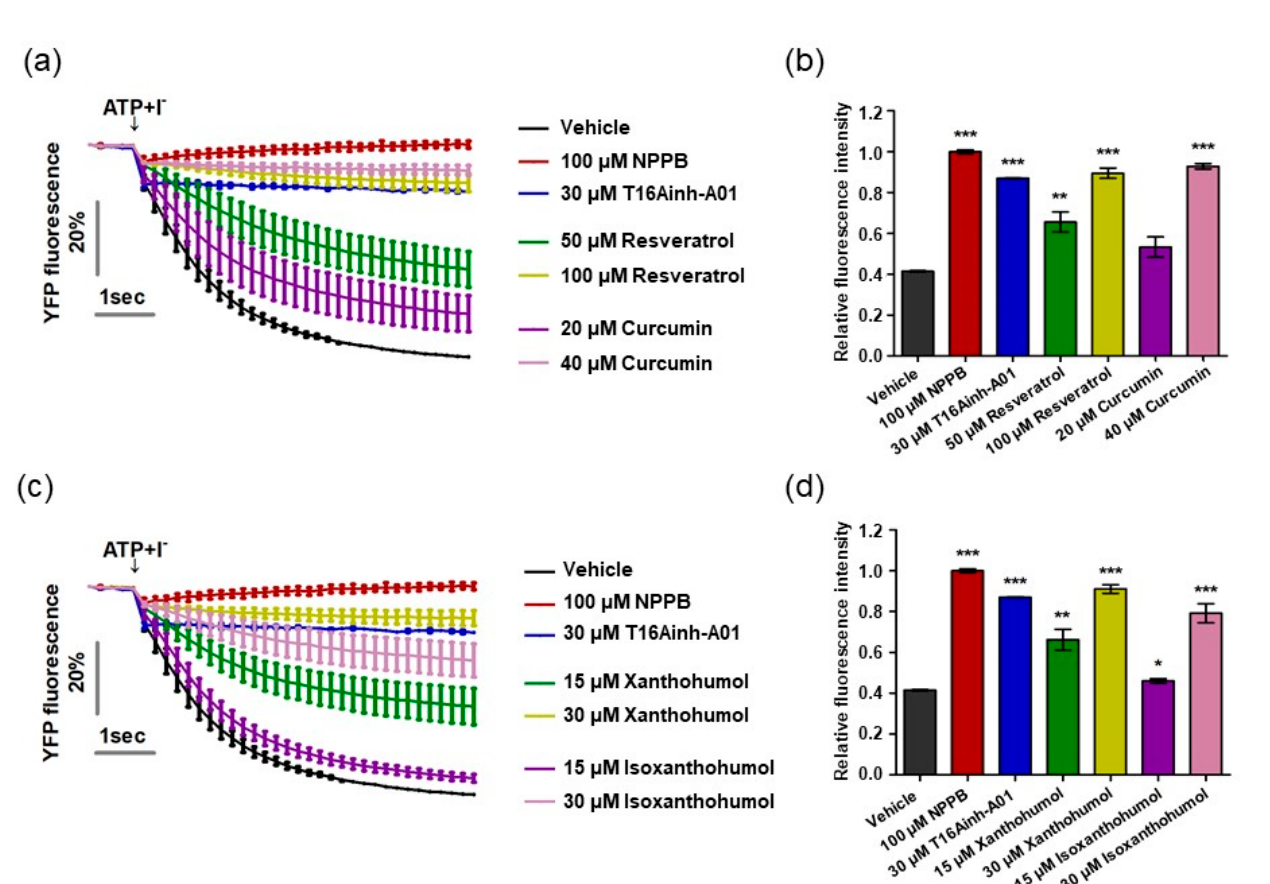
Figure 3. Inhibition of ANO1 channel activity by resveratrol, curcumin, xanthohumol, and isoxanthohumol. The activity of ANO1 was measured in Fischer rat thyroid (FRT) cells stably co-expressing human ANO1 and the yellow fluorescent protein (YFP). After the cells were exposed to positive controls (NPPB and T16Ainh-A01) or one of the four compounds for 20 min, they were treated with 140 mM NaI solution containing 100 µM ATP to activate ANO1 channel activity, continuously measured every 0.2 s for 6 s. ( a ) Fluorescence intensity of cells exposed to vehicle, positive controls, resveratrol, and curcumin. ( b , d ) Relative fluorescence intensity obtained from tested cells at 6 s. ( c ) Fluorescence intensity of cells exposed to vehicle, positive controls, xanthohumol, and isoxanthohumol. To compare the differences among vehicle, positive controls, resveratrol, curcumin, xanthohumol, and isoxanthohumol, two-way ANOVA and Tukey’s post-hoc tests were used. *: significantly different from vehicle (* p < 0.05, ** p < 0.01, and *** p < 0.001).